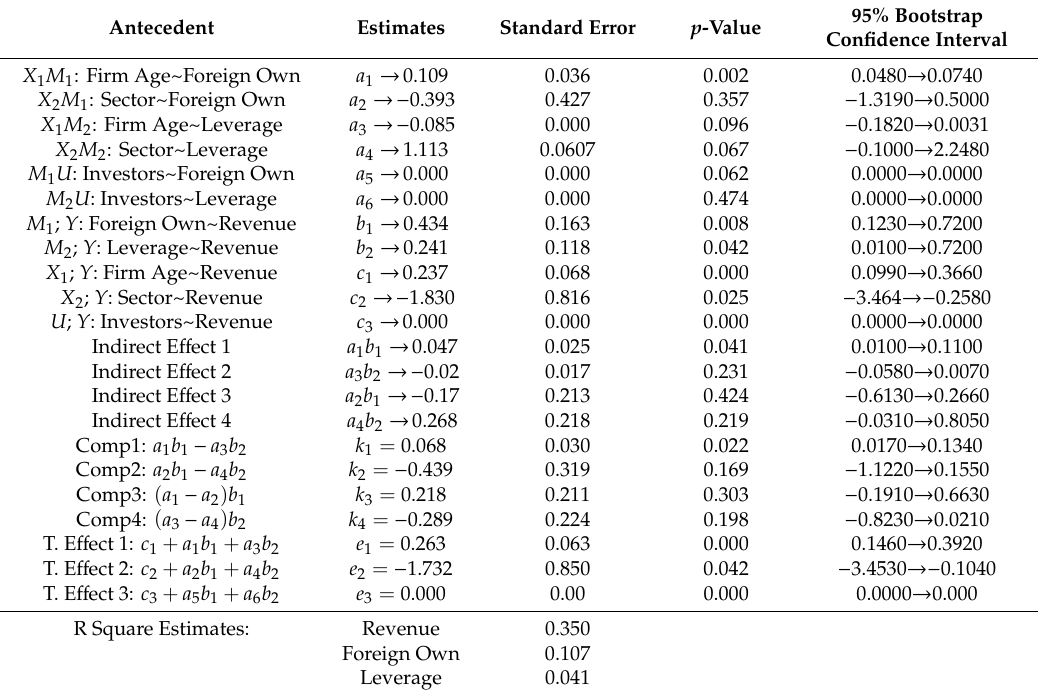
Table 2. Structural equation modeling (SEM) estimates with confidence intervals and standard errors highlighting firm age and business sector’s e ff ect on financial performance based on R